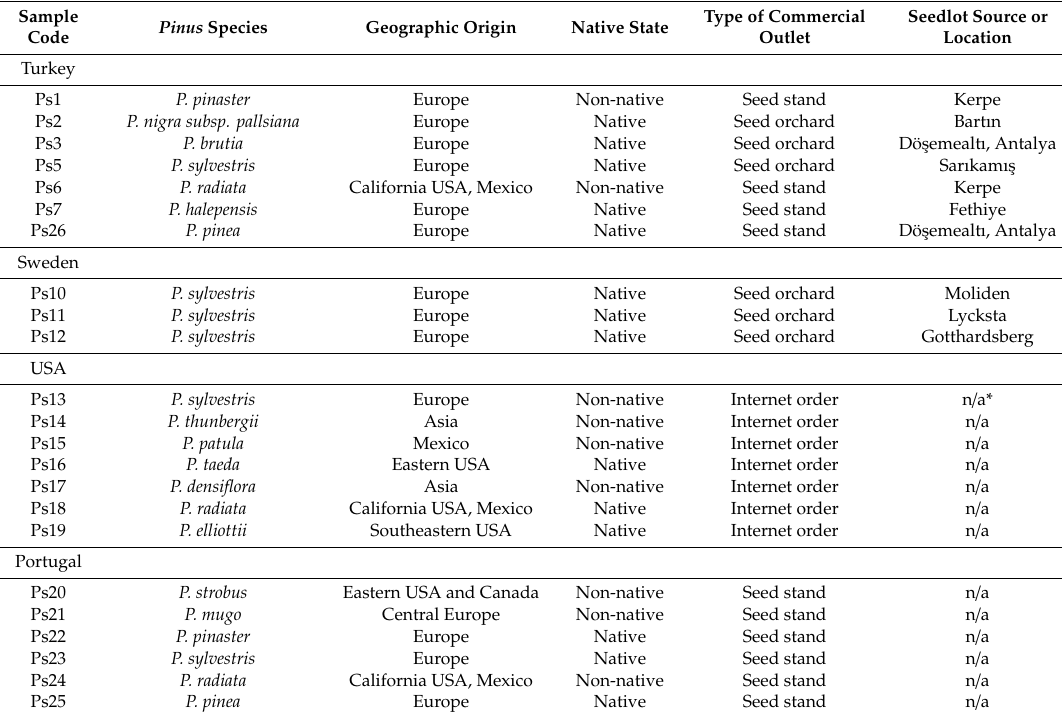
Table 1. Pinus species, source origin, and type of commercial outlet that seedlots were sourced from the four di ff erent